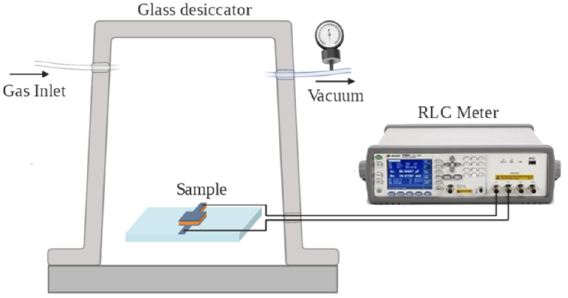
Figure 5. Setup used for the characterization of the zeolite-based capacitor for gas sensing (not to scale).